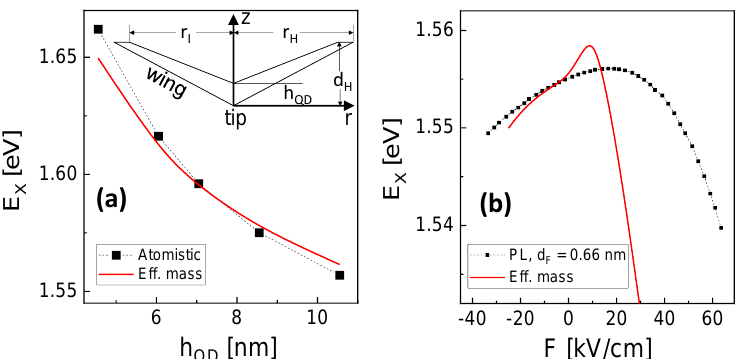
Figure 2. ( a ) Comparison of exciton energies E X as a function of the CSQS height h QD simulated with the atomistic model as reference (the data are taken from [11]) and with the present effective mass model. The inset shows a cross section of the assumed CSQS shape, with d H = 30 nm, r H = 56.5 nm, r I = 49.4 nm, and varied h QD . For positive values of F , the electric field points from the tip to the base of the cone; ( b ) comparison of the measured exciton Stark shift of a sample with a deposited filling layer thickness d F = 0.66 nm with results of the effective mass model using the CSQS shape from ( a ) and h QD = 10.6 nm. This choice of h QD reproduces E X at F =